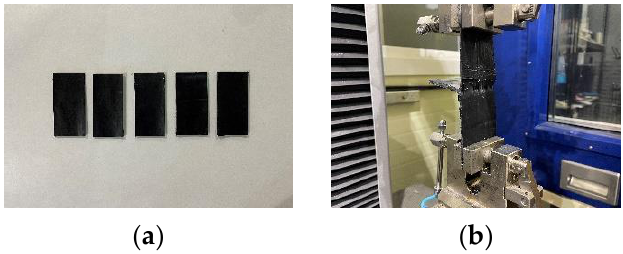
Figure 7. Peel-out (between sheet joint) test specimen preparation and test status. ( a ) Preparing for the test. ( b ) Test status.